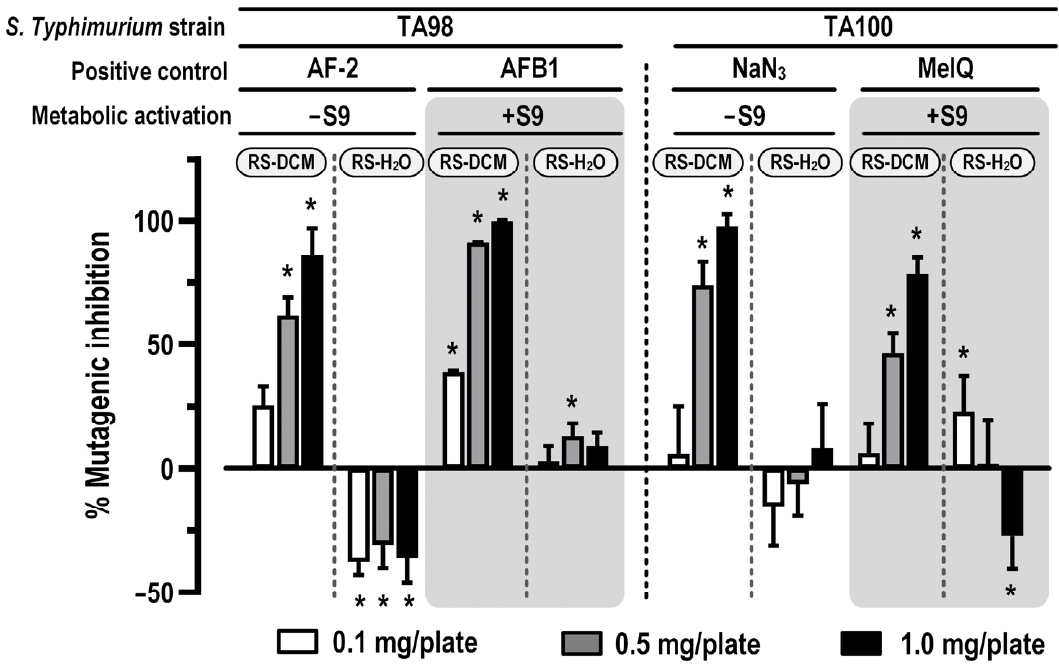
Figure 6. In vitro antimutagenic activity of RS in TA98 and TA100 strains of S . Typhimurium with non-metabolic ( − S9) and metabolic (+S9) activation. The values are expressed as mean ± SD. The data were distributed normally (Shapiro–Wilk: p > 0.05) and were analyzed for statistical significance using one-way ANOVA with LSD’s post hoc test. * Significantly different from positive control (set as 0% mutagenic inhibition ).